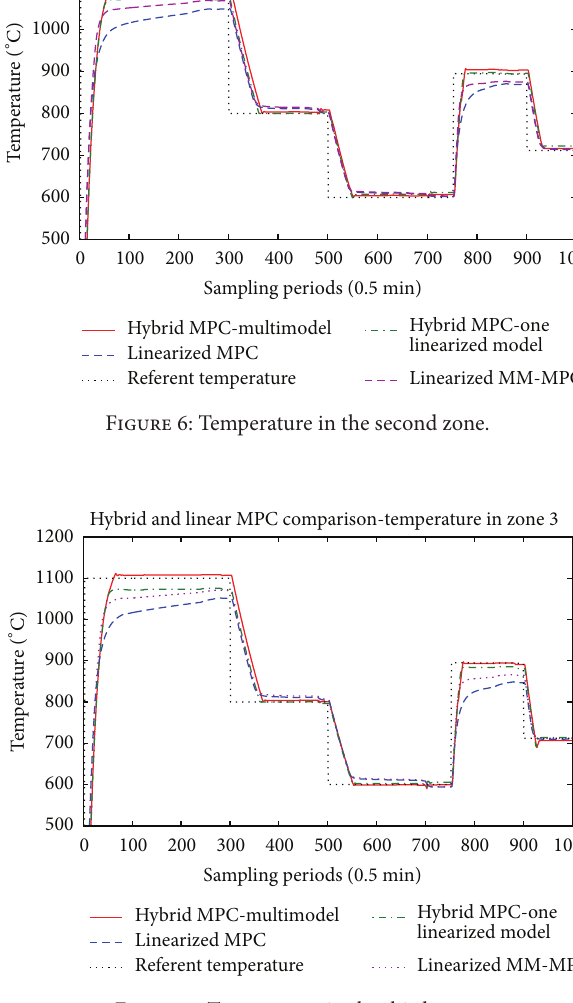
Figure 7: Temperature in the third